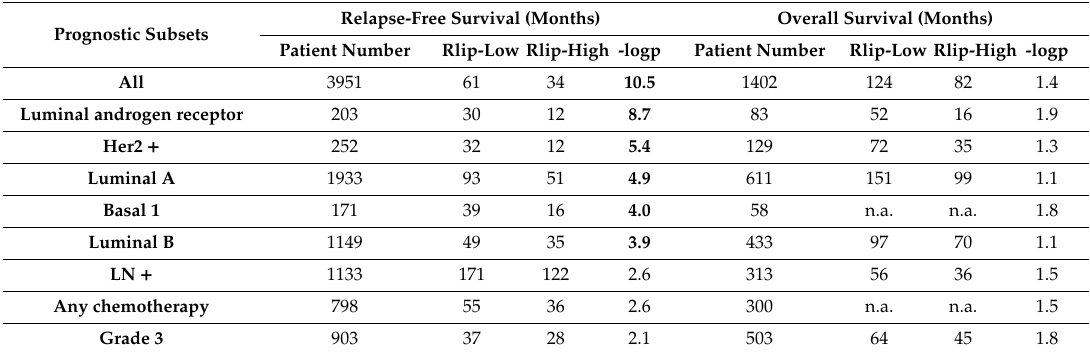
Table 2. Survival in Breast Cancer According to Rlip